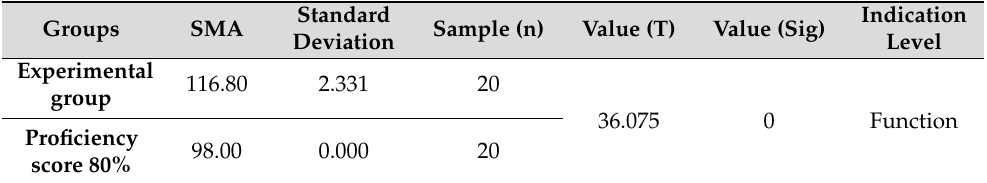
Table 6. Significance of differences between average scores of experimental group and specific degree of proficiency 80% in skill test of practical experiment